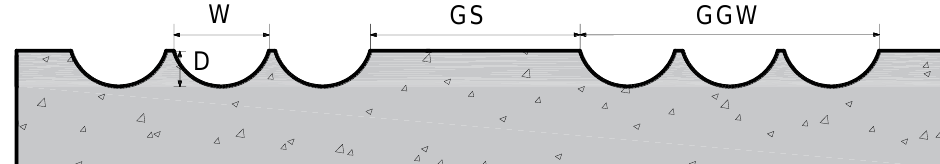
Figure 11. New curved groove parameters (W: the curved groove width, mm; D: the curved groove